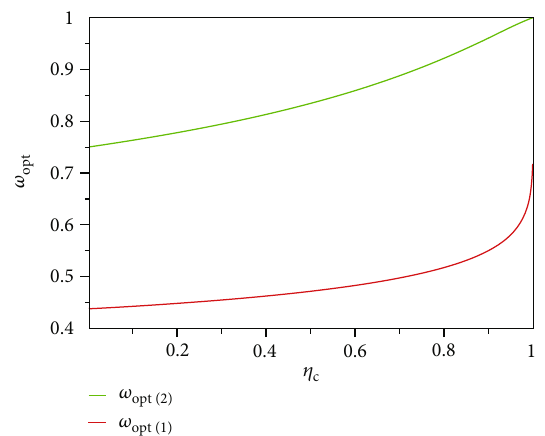
Figure 6: The numerical values of the ratio of optimized power for the two cases of optimization criteria to the maximum power versus the Carnot e ffi ciency.